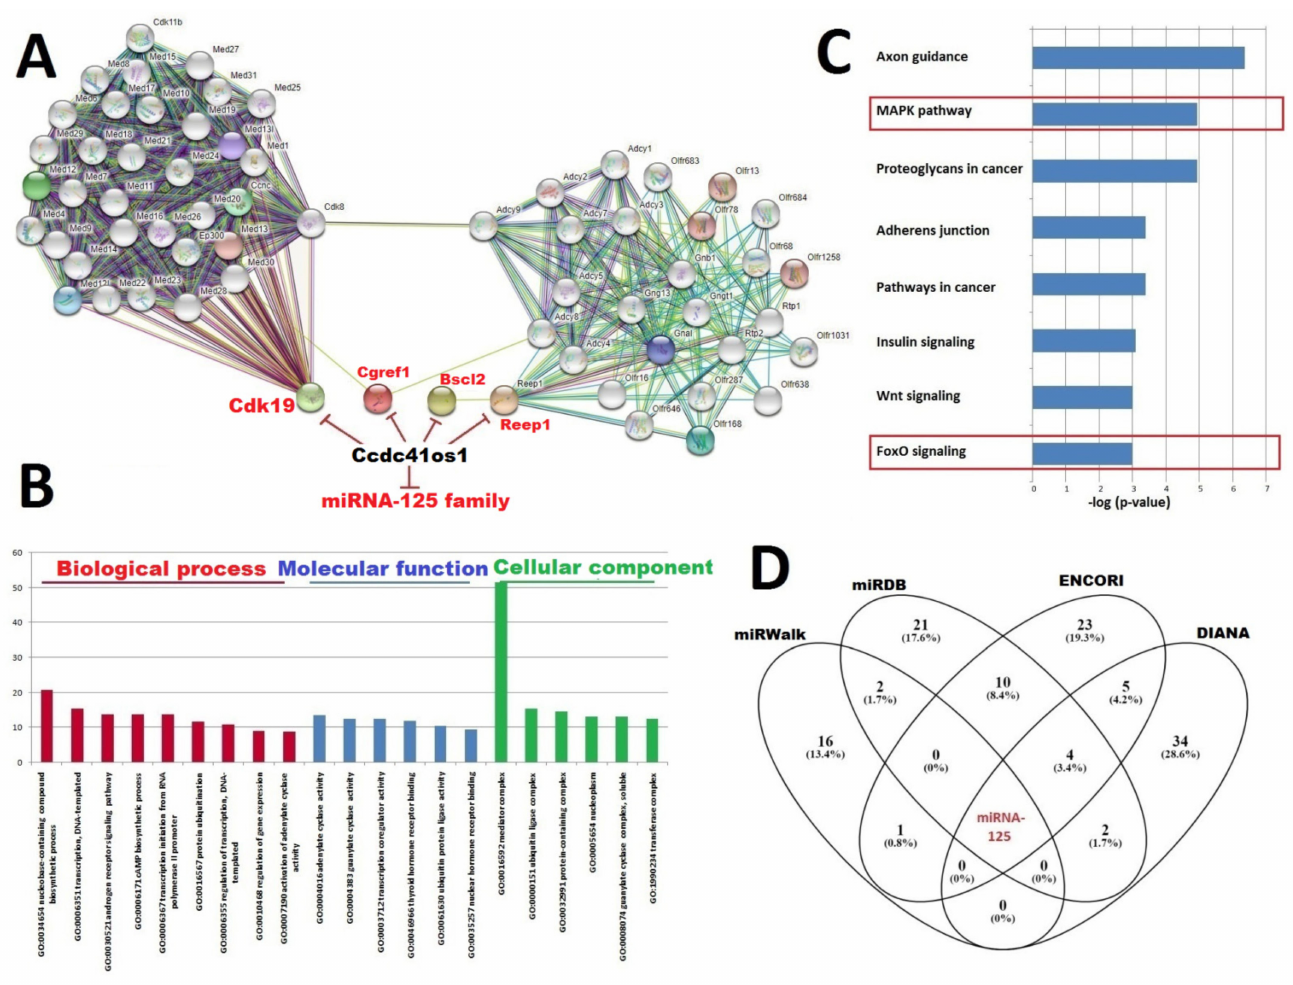
Figure 5. Bioinformatics analysis for Ccdc41os1: ( A ) constructed protein–protein interaction (PPI) network and predicted miRNA-125 interacting with Ccdc41os1; ( B ) result of GO enrichment analysis and top, most significantly enriched terms for predicted genes; ( C ) result of KEGG enrichment analysis and top, most significantly enriched terms for predicted genes (the key pathways related to muscle atrophy were marked); ( D ) Venn diagram illustrating the compatibility between miRNA prediction by different